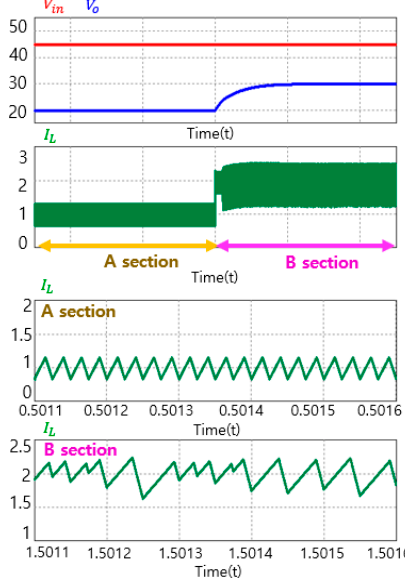
Figure 9. Inductor current waveform for changing output voltage.